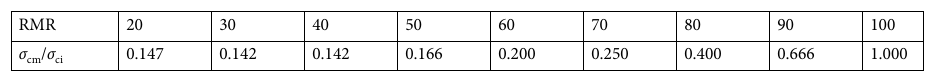
Table 7. Estimated values of σ cm / σ ci proposed by Asef et al. 14